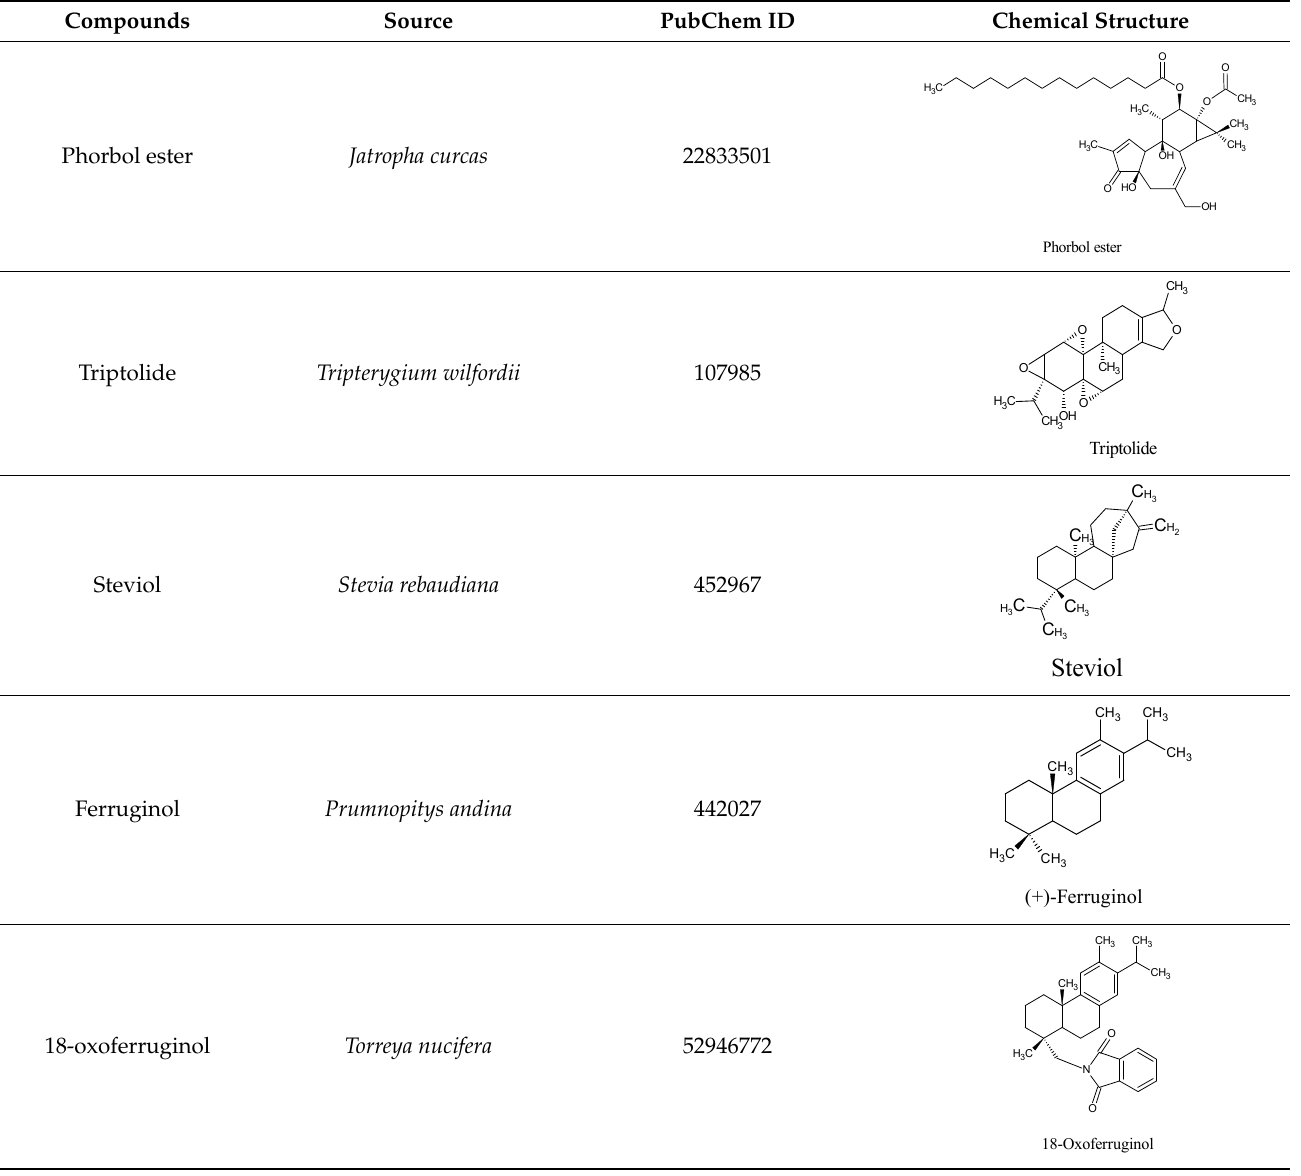
Table 8. Diterpenes/diterpenoids and their derivatives with bioactivity against DENV and DENV-infected experimental animals or cell lines.